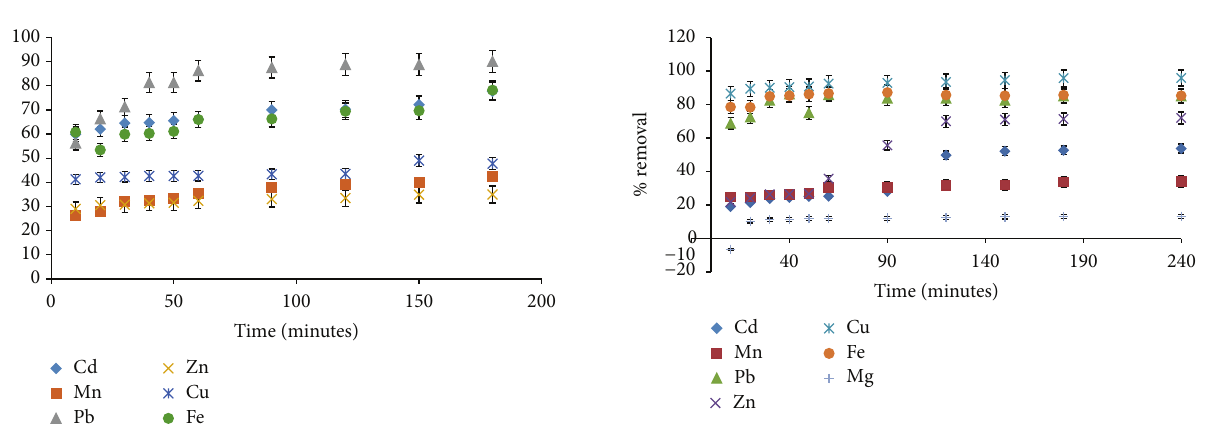
Figure 5: Effect of contact time on metal removal using MSP (all other variables in Section 2.6 constant).